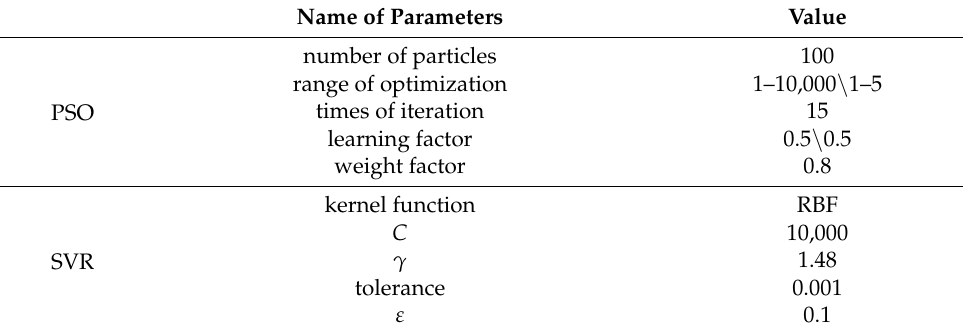
Table 2. Parameters of performance prediction